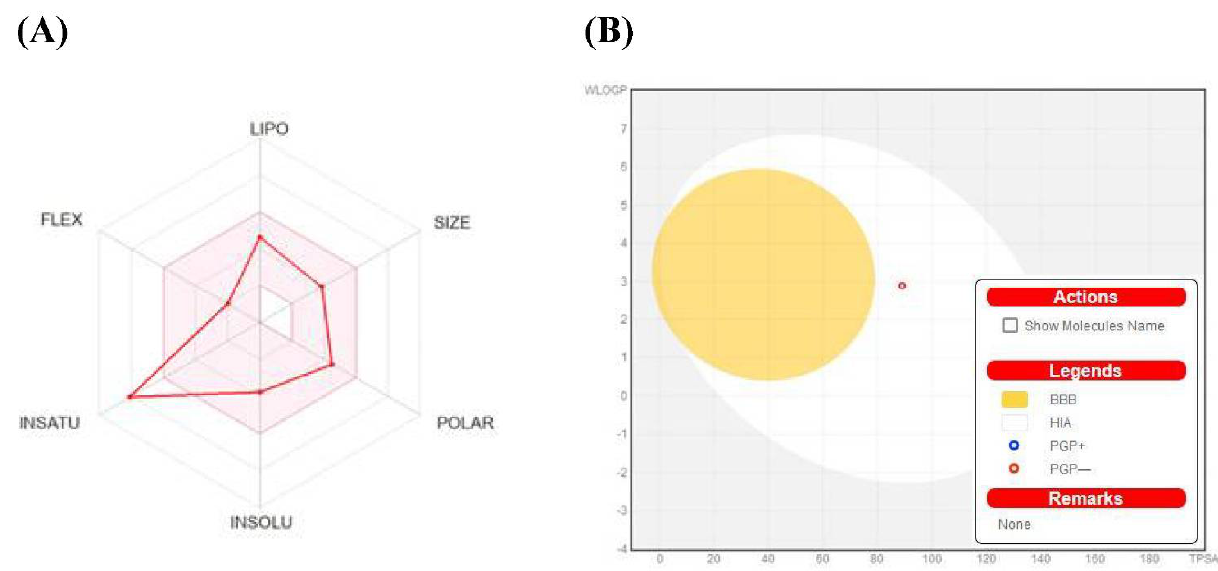
Figure 7. ( A ) Bioavailability radar chart for isolated flavone. The pink zone represents the physico- chemical space for oral bioavailability, and the red line represents the oral bioavailability properties. ( B ) Predicted BOILED—Egg plot from swiss ADME online web tool for isolated